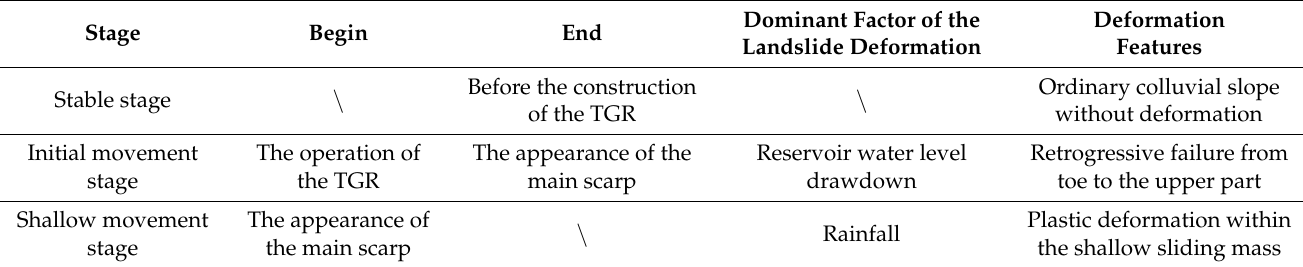
Table 5. Summary of the landslide development